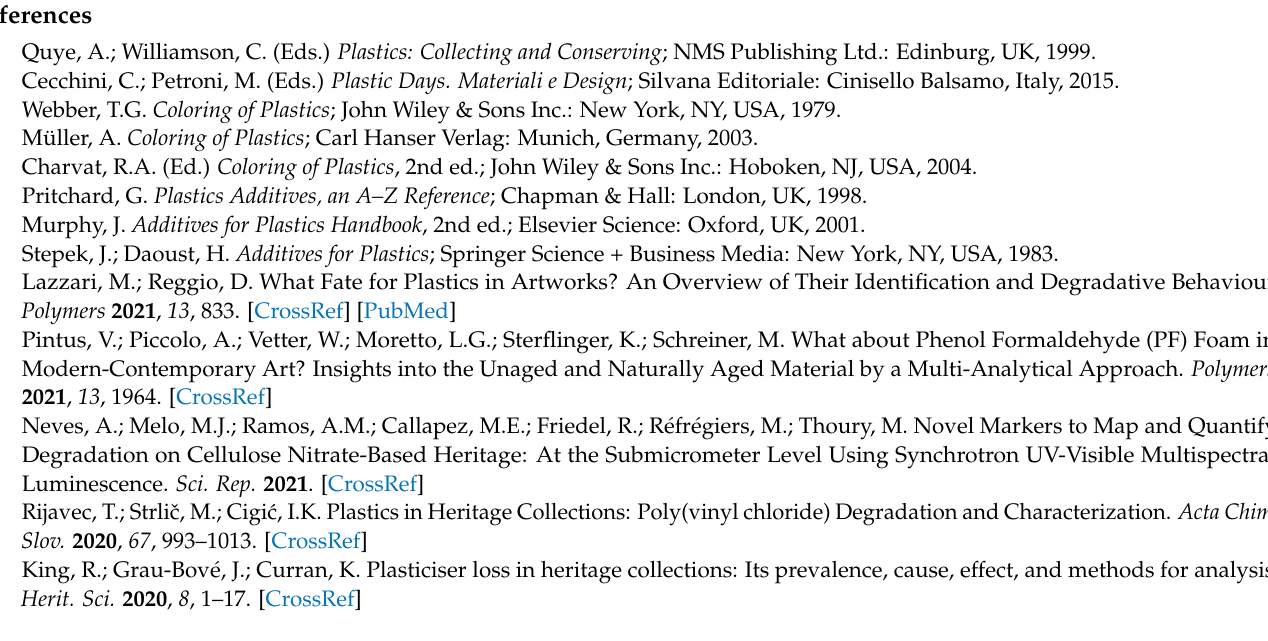
Table S5: Main volatile organic compounds detected in the red PS lid 3 (characteristic ions in mass spectra: molecular weight, M w , in bold and base peak underlined). Additives are marked in italic